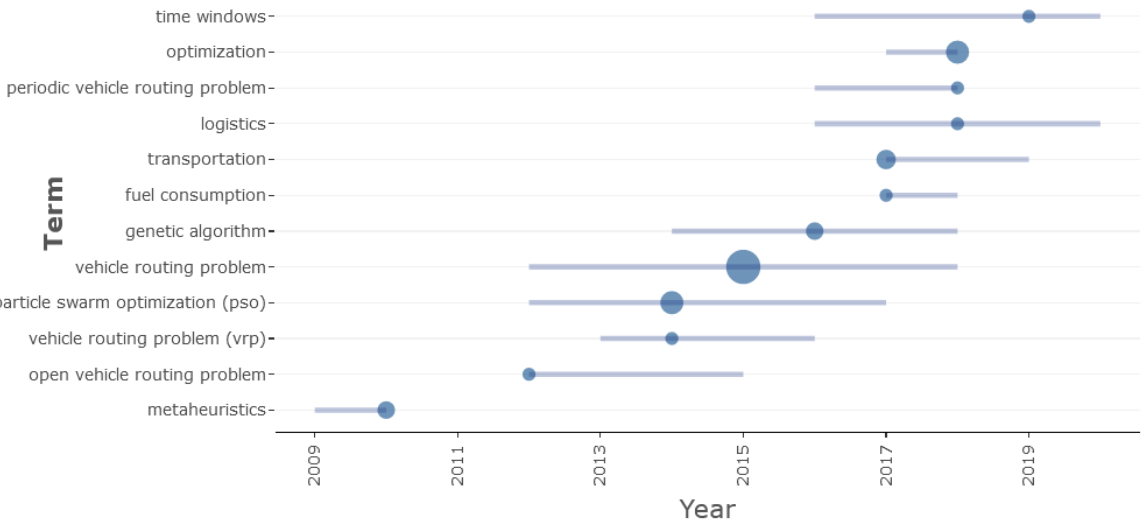
Figure 7. Author’s Keywords Thematic Evolution, three words/year; three-word minimum frequency.